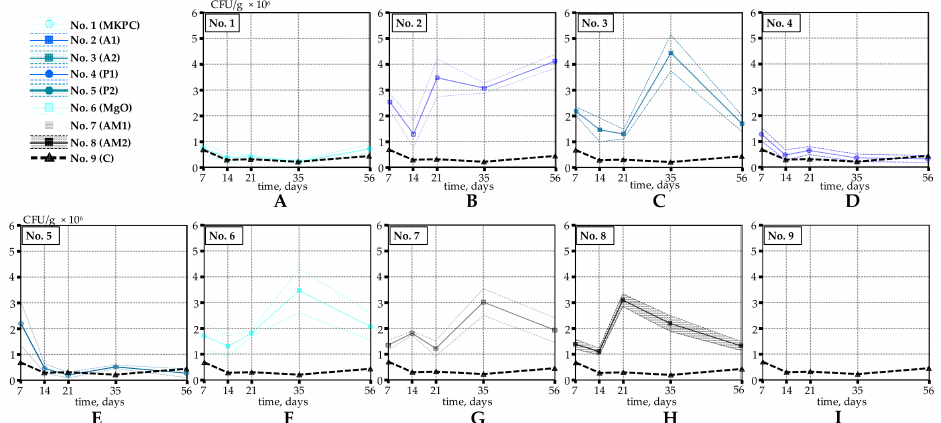
Figure 4. Bacterial viability in concrete specimens produced with expanded clay particles coated with: ( A ) potassium magnesium phosphate cement; ( B , C ) one and two layers of styrene–acrylate emulsion, respectively; ( D , E ) one and two layers of waterborne, latex and acrylic-composite paint, respectively; ( F ) magnesium oxide and magnesium hydroxide; ( G , H ) styrene–acrylate and magnesium oxide solution, prepared with a ratio 10:1 or 30:1, respectively; ( I ) uncoated control specimens. Solid lines in the graphs represent the average values, whereas shaded areas depict the 95% confidence